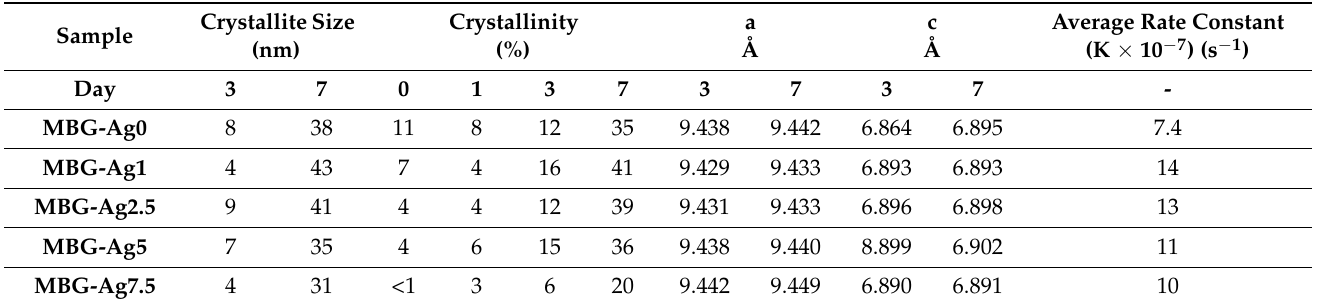
Table 4. Rietveld refinement study of the un-doped, 1, 2.5, 5, and 7.5 mol% Ag-doped